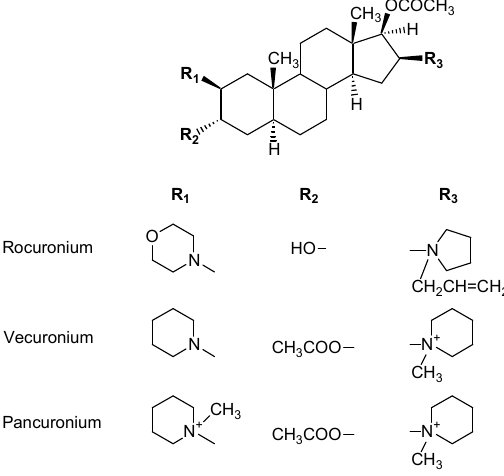
Figure 16. Structures of the non-depolarizing and competitive aminosteroid NMBDs rocuronium, vecuronium and pancuronium. From Baldo B.A. et al. [39]. Reproduced with permission from Bentham Science